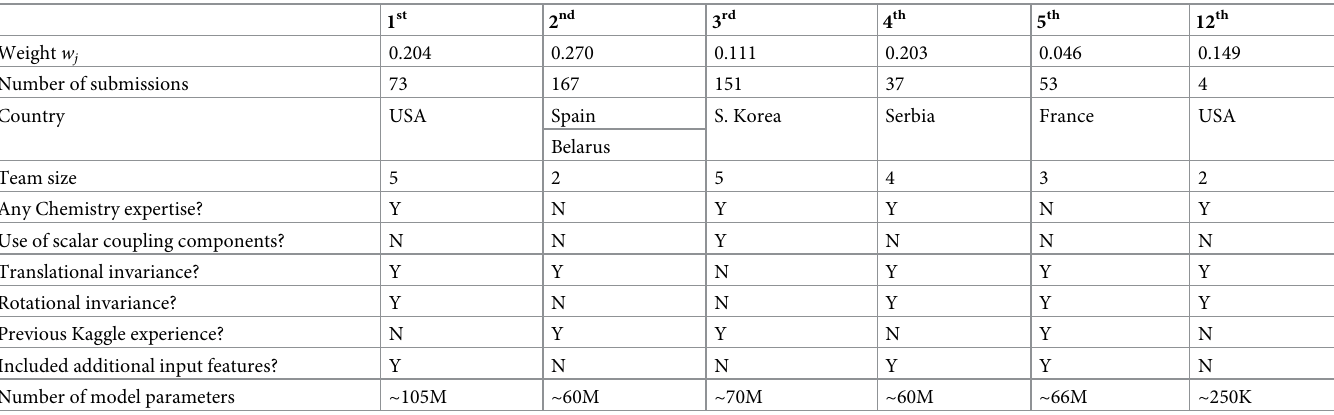
Table 1. Summary descriptions for the six models in the final